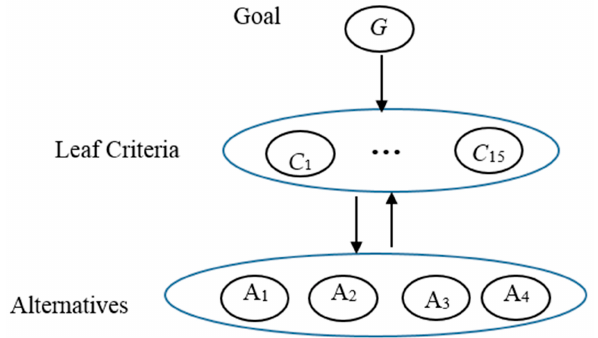
Figure 9. ANP network structure for the Supply Chain Sustainability problem.